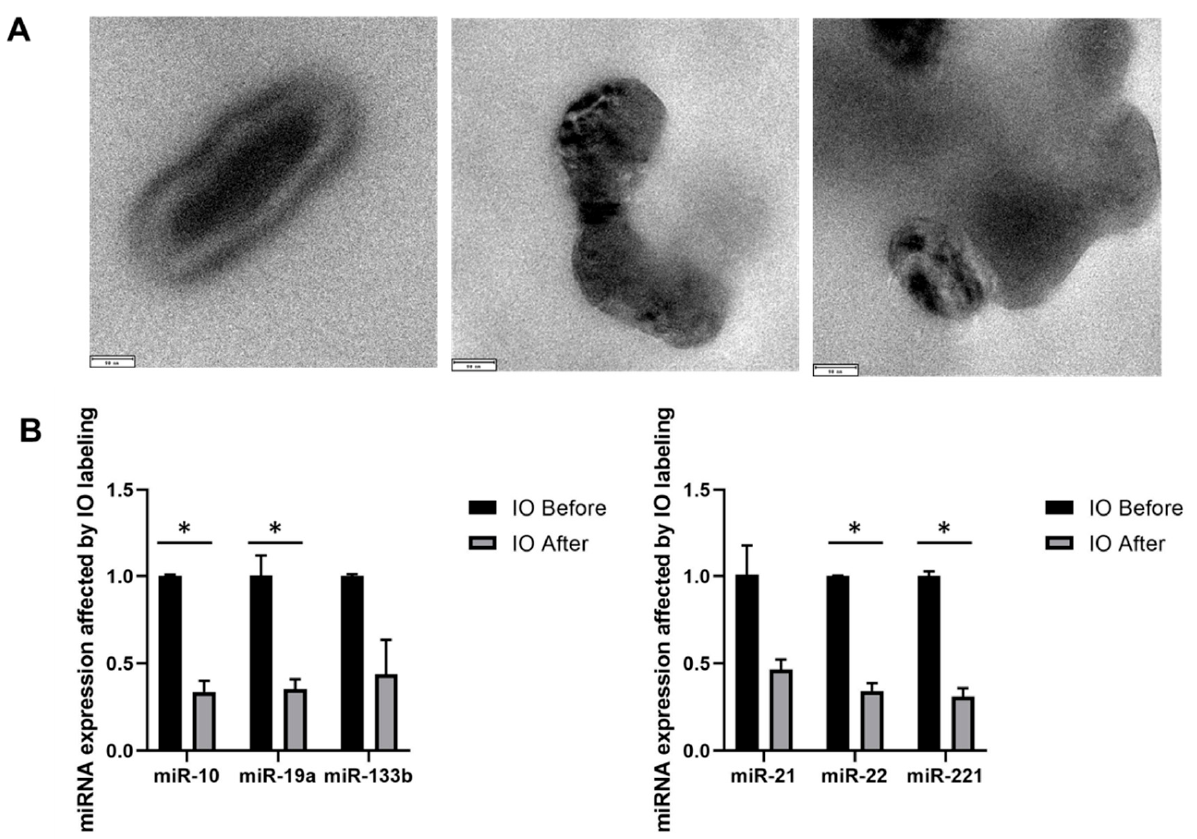
Figure 3. miRNA cargo for Organoid − EV before and after sonication and labeling. ( A ) Images of transmission electron microscopy (TEM) for EV morphology; Scale bar: 90 nm. ( B ) miRNA expression in the EVs before and after sonication determined by RT-PCR ( n = 3), * indicates p < 0.05.